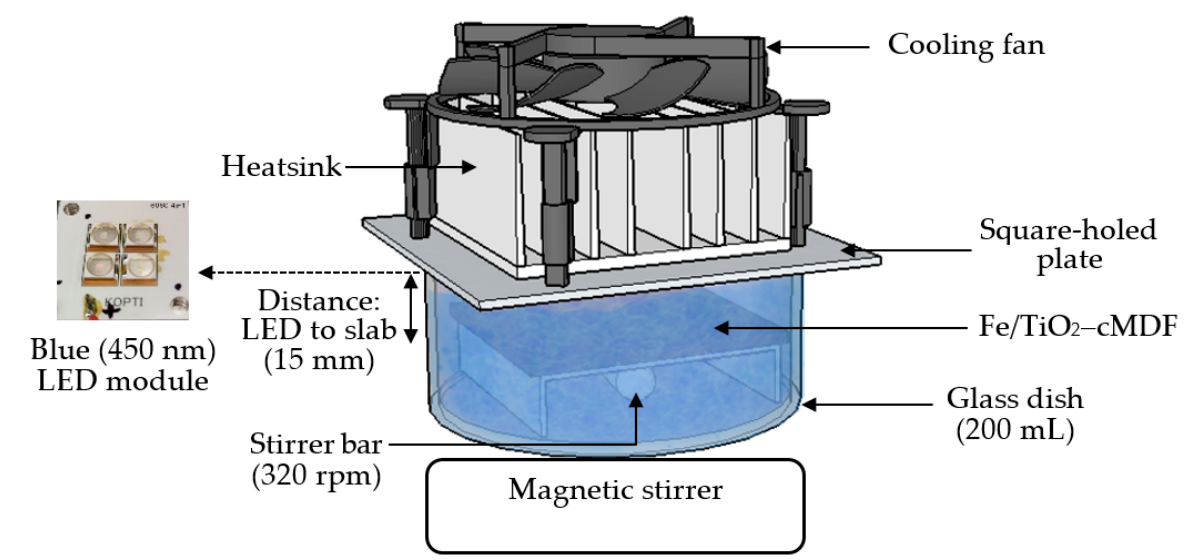
Figure 3. Representation of the photodegradation experiment under Blue LED.